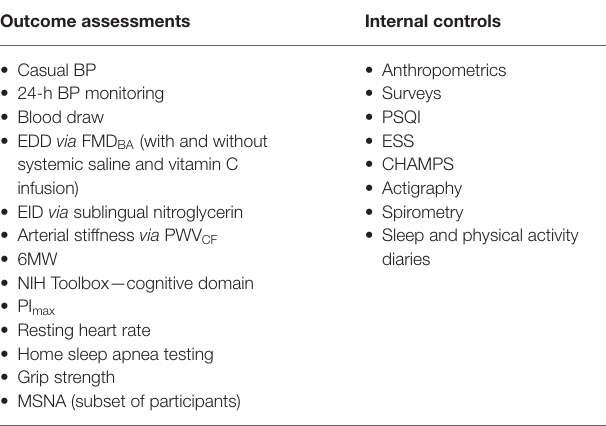
TABLE 3 | Outcome assessments and internal controls. Outcome